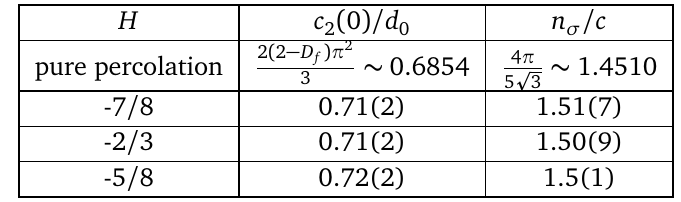
Table 8: Cylinder limit c central charge c , obtained from fit (37), for surfaces